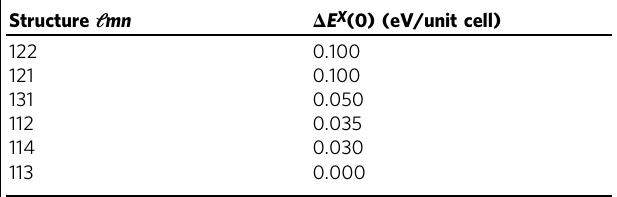
Table 1 Energy differences Δ E X (0) of the six lowest energy ℓ mn structures with respect to the ground state phase 113 ( Δ E X (0) is explained in the main